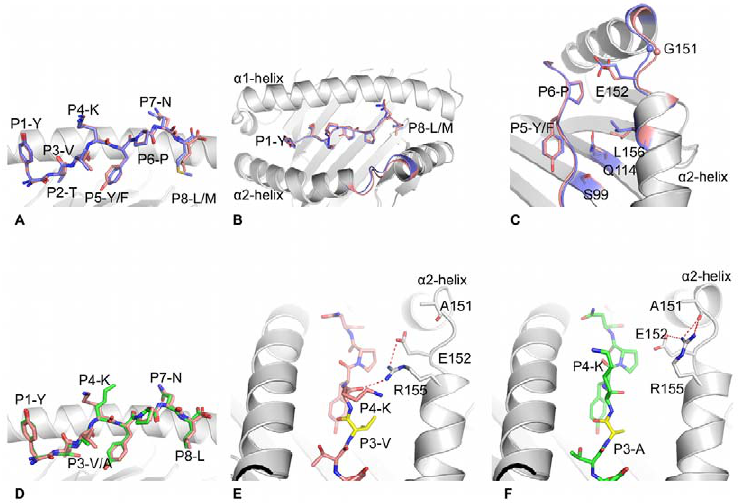
Figure 1. Analysis and comparisons of NP205-K b structures. (A), (B) and (C): superposition of LCMV (pink) with PV (blue) structures, with the peptide in stick representation and the MHC H2K b in grey cartoon. The tip of the a 2-helix is colored accordingly to the peptides bound by the H2K b molecules, representing the section from residue 150 to 156 of the a 2-helix (B & C). (C) shows, with a different orientation, the residues that change conformation between the peptide-MHC complexes, namely Serine-99, Glutamine-114, Leucine-156, Glutamate-152 as well as Glycine-151, for which the C a atom is represented by a sphere. (D) superposition of the LCMV (pink) with LCMV-V207A (green) structures, with peptide in stick representation and MHC in grey cartoon. (E) and (F): comparison of LCMV (pink) and LCMV-V207A (green) mutant peptide, both bound to the H2K b molecule (grey cartoon) in the same orientation. The P3 residues are colored in yellow. Arginine-155, Glutamate-152 and Alanine-151 of the H2K b molecule are represented as grey stick to show the different interaction of their side chains between both structures. The red dashed lines represent the hydrogen bond made between the residues.